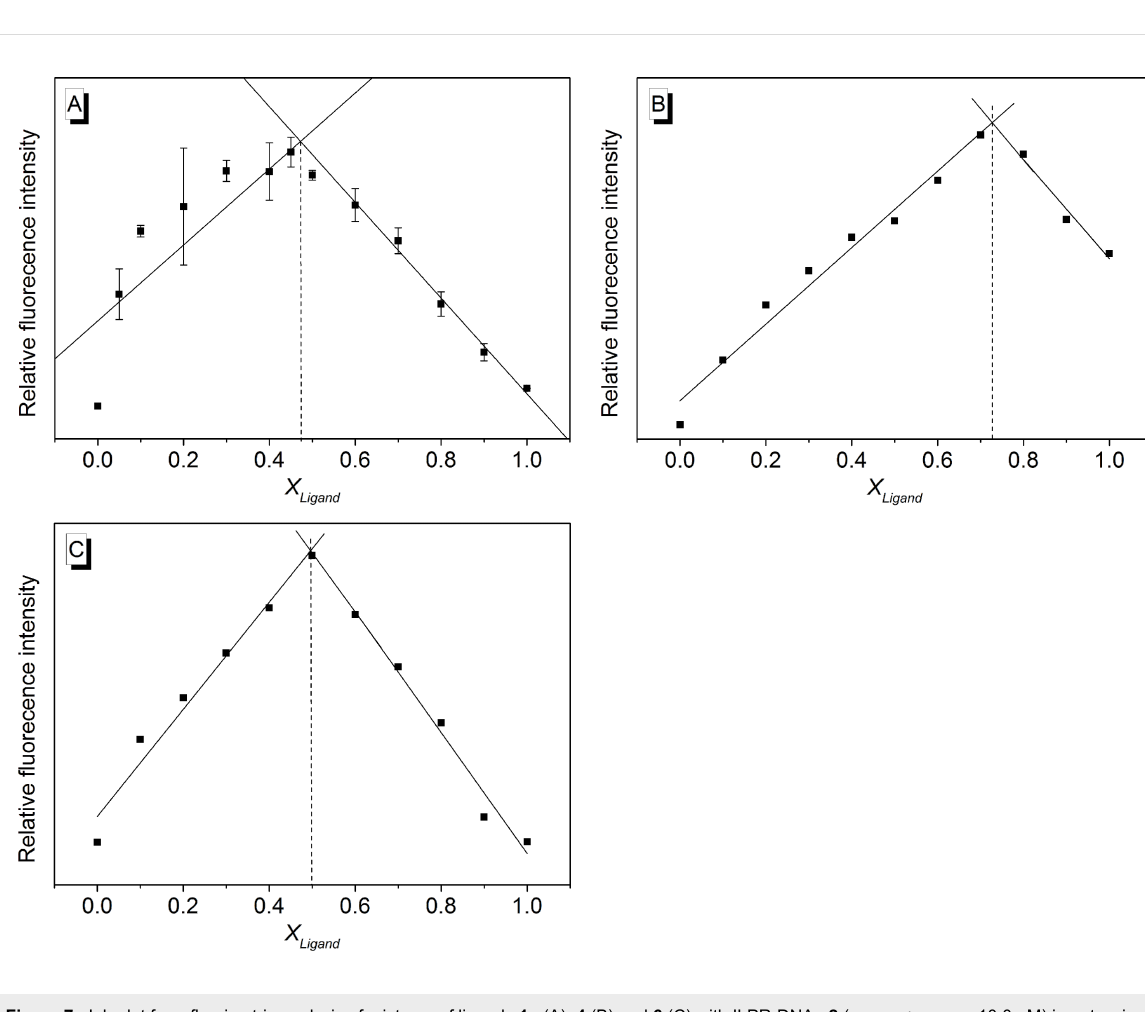
processes. Nevertheless, to provide comparable data, in this